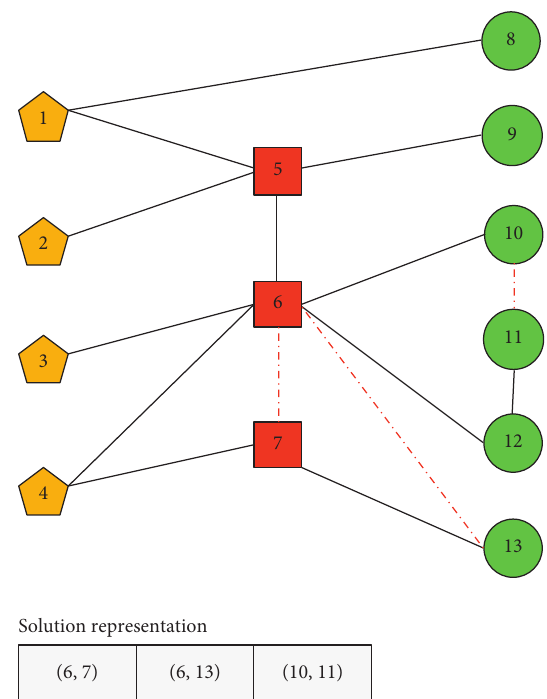
Figure 3: Illustration of string-based solution